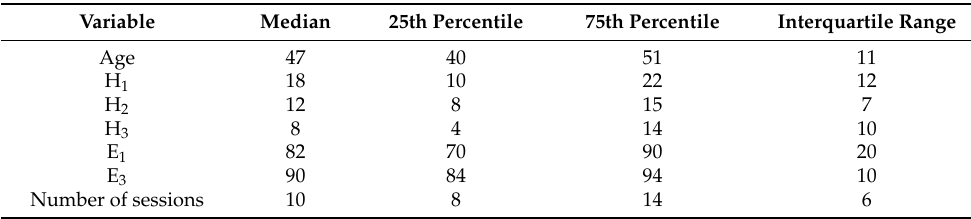
Table 1. Descriptive analysis of the sample ( n = 35) of health professionals of a regional hospital in Spain. Variable Median 25th Percentile 75th Percentile Interquartile Range Age 47 40 51 11 H 1 18 10 22